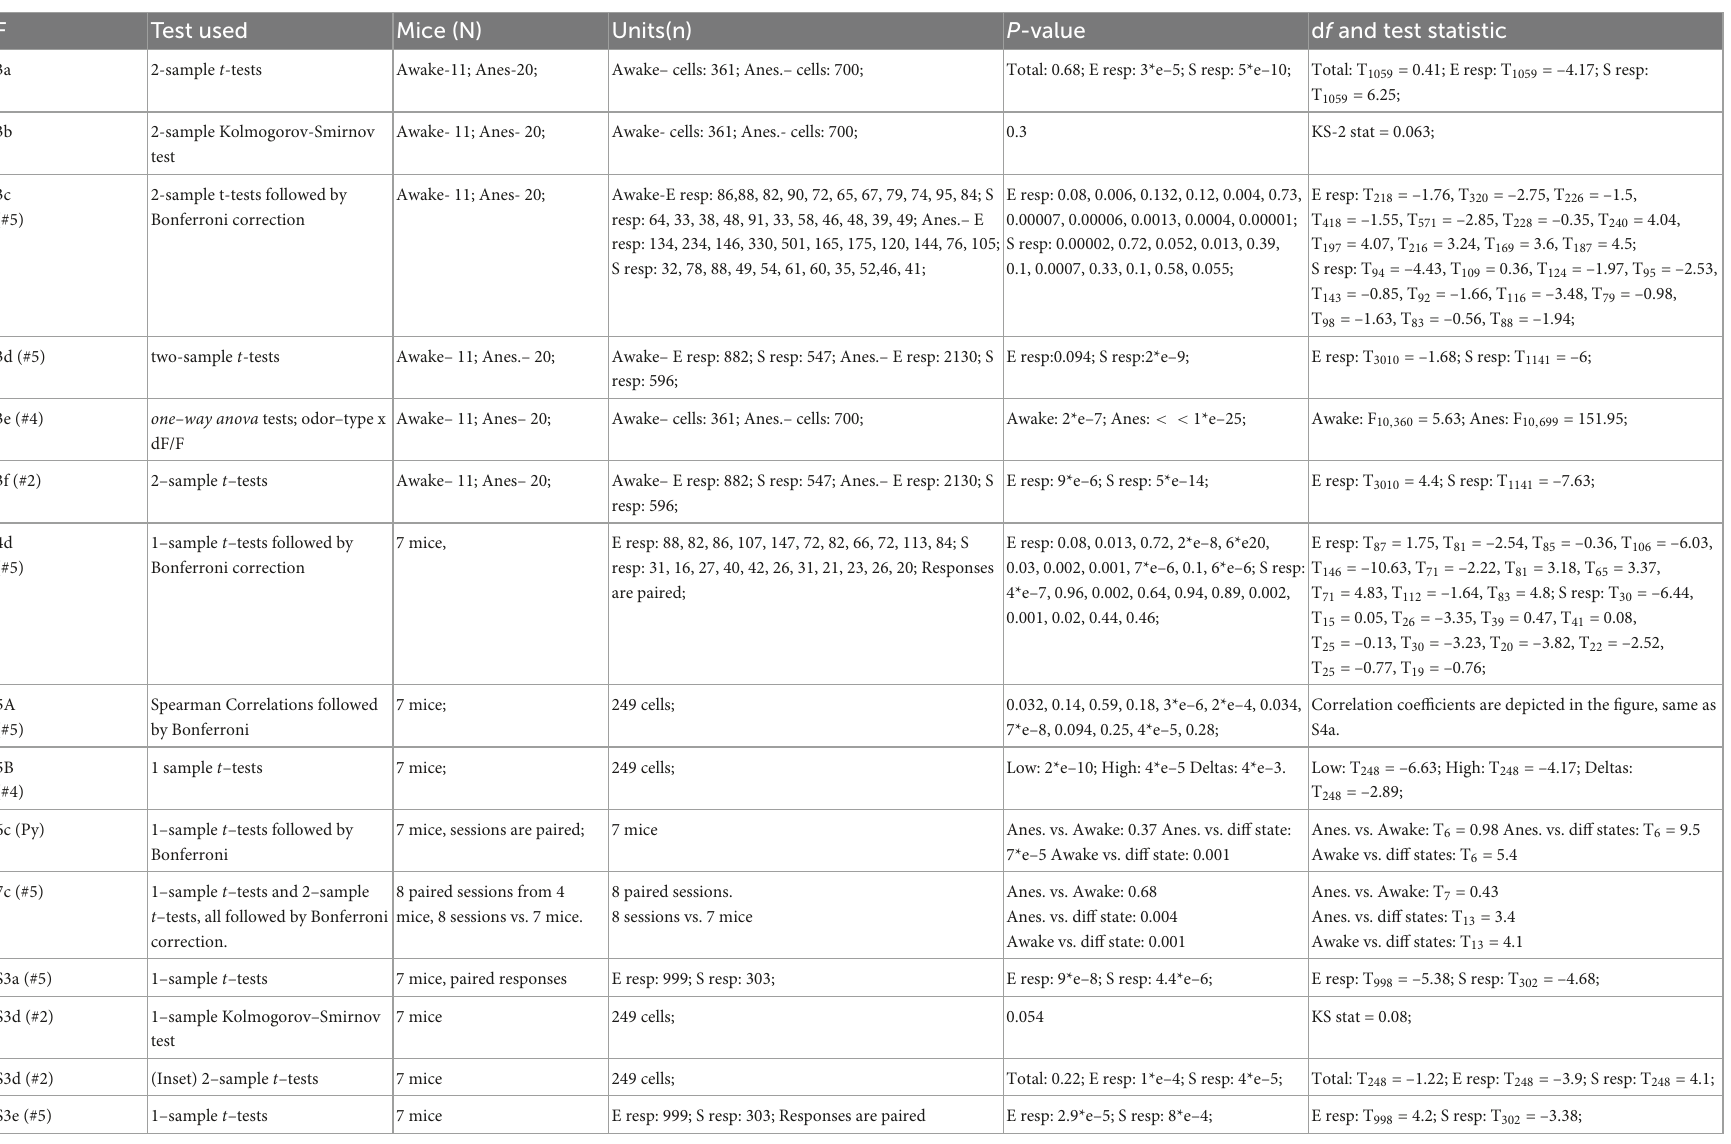
TABLE 1 Details of statistical